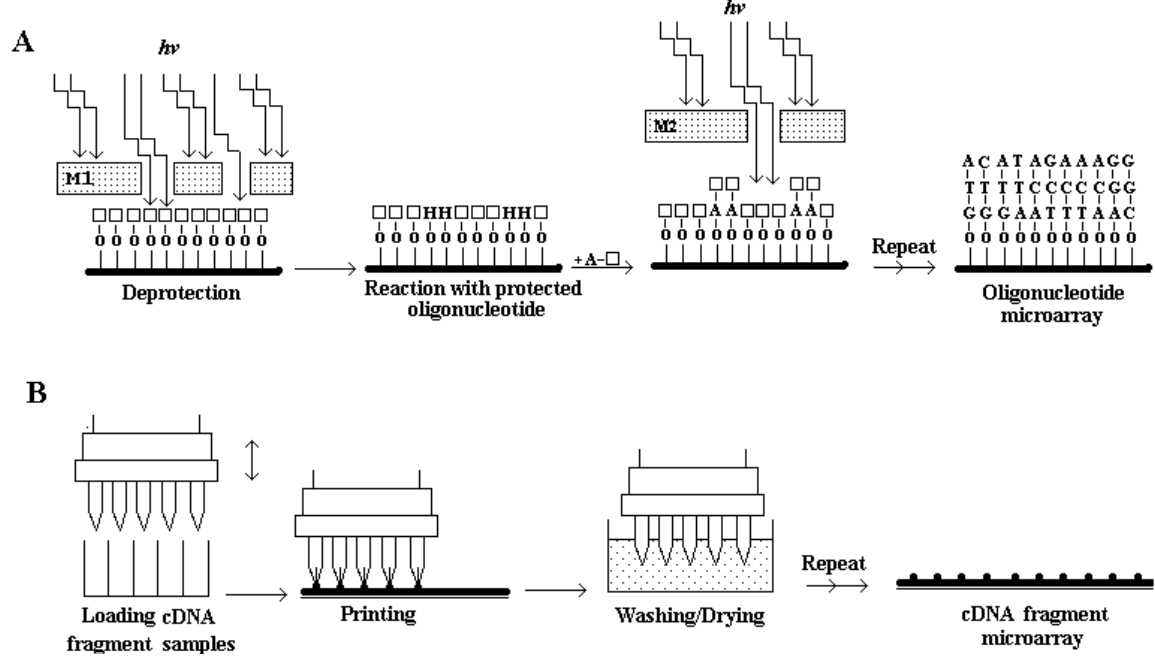
Figure 2 - Examples of two approaches to generate microarrays. A , Photolithography: a glass slide having protected spacer groups is selectively deprotected by shining light through photolithographic masks (M1 and M2). The activated groups react with a protected base (A- , in the example). Repeated deprotection and reaction with different masks result in high-density oligonucleotide microarrays. B , Array of cDNA fragments: the fragment samples are loaded into pins by capillary action and printed on a glass surface covered with polylysine. The pins are washed, dried and used to load more